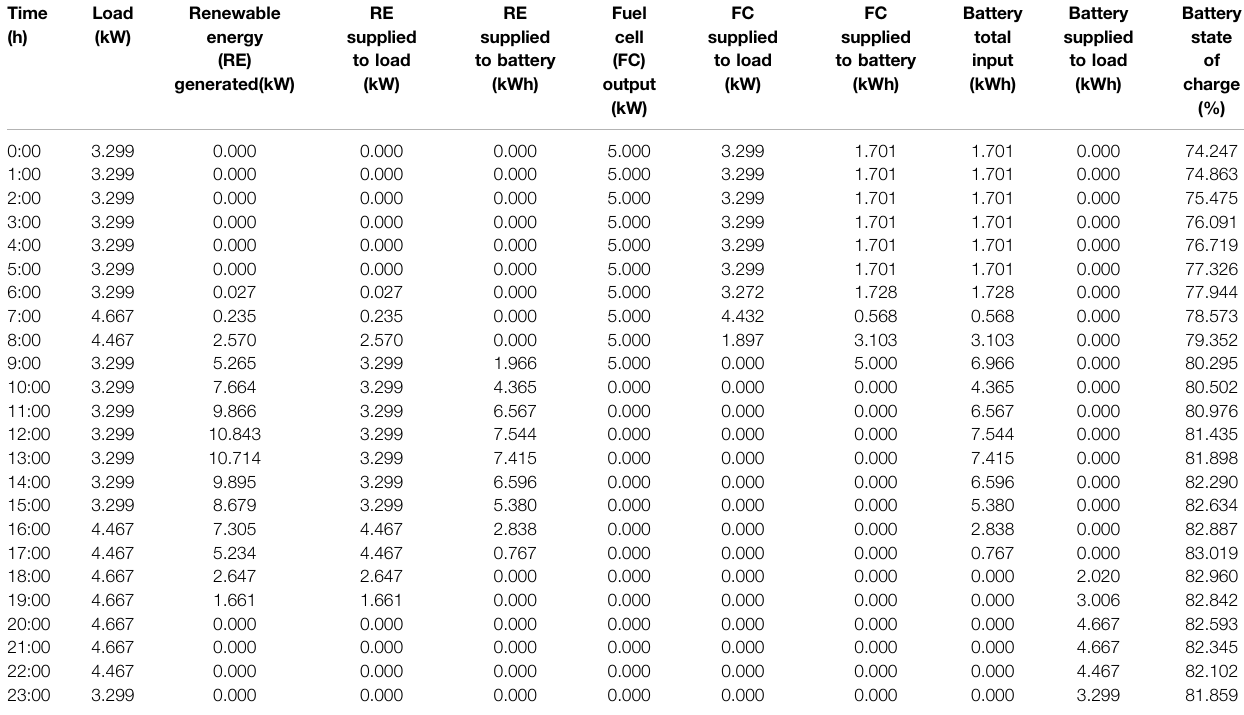
TABLE 3 | Power demand met by the integrated renewable energy system (PV and wind) in day